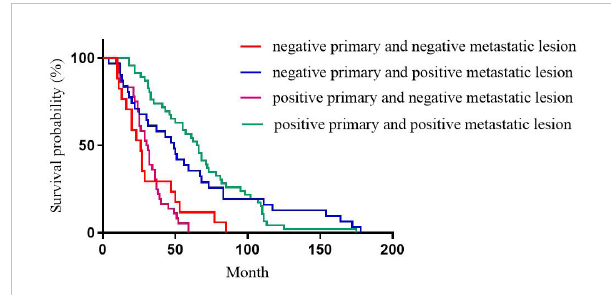
FIGURE 1 Correlation between ER expression heterogeneity and patient